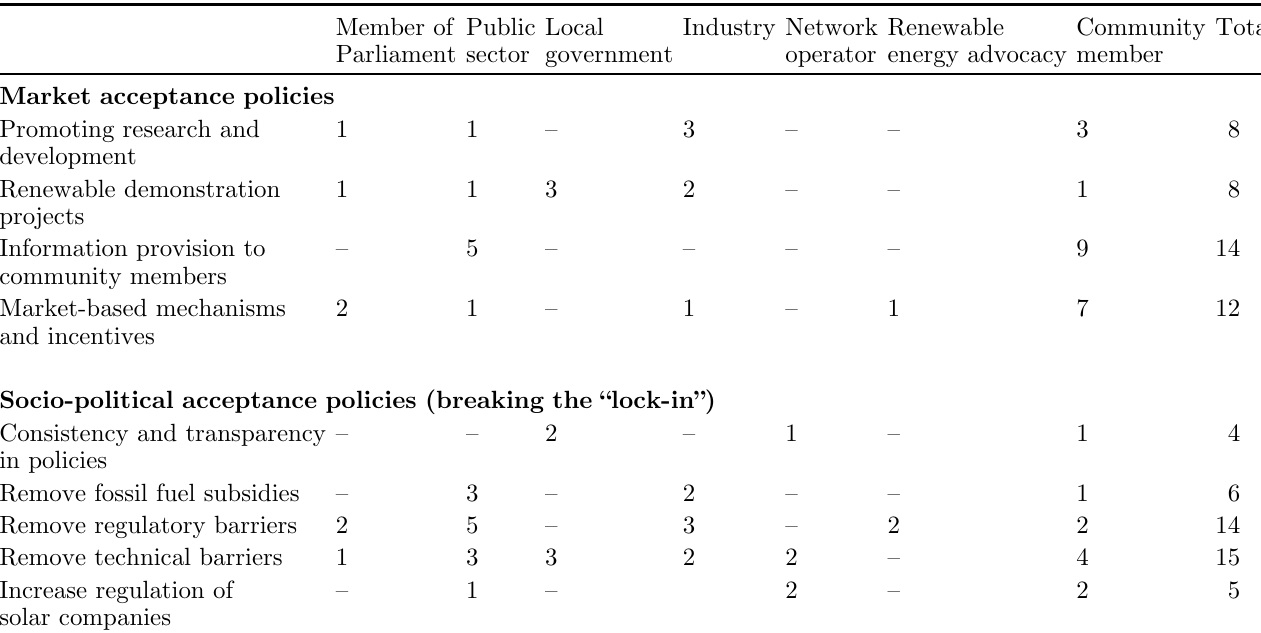
Table 2. Potential policy approaches to promoting renewable energy suggested by respective stakeholder groups during